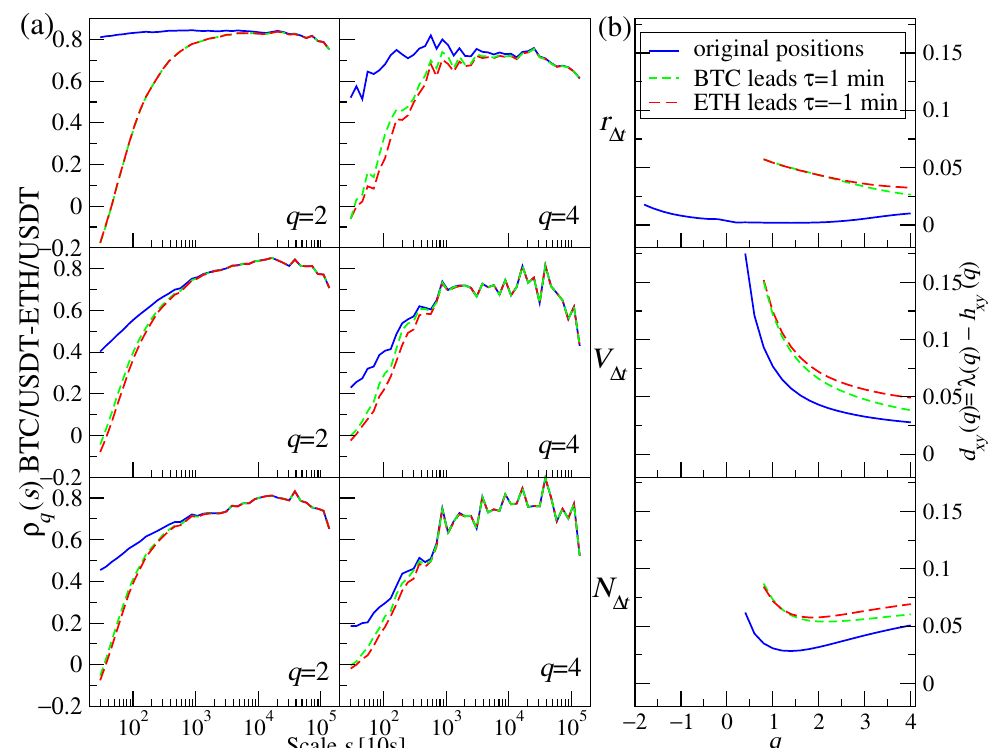
Figure 5. ( a ) The q -dependent detrended cross-correlation coefficient ρ q ( s ) for q = 2 ( left ) and q = 4 ( right ) calculated for time series of price returns r ∆ t ( t ) ( top ), volume traded V ∆ t ( t ) ( middle ), and the number of transactions N ∆ t ( t ) in ∆ t ( bottom ) for X = BTC and Y = ETH. Three cases are considered: both time series are simultaneous (solid blue), time series representing BTC is advanced by τ = 1 min (short-dashed green), and time series representing ETH is advanced by τ = 1 min (long-dashed red). ( b ) Difference d XY ( q ) between the bivariate scaling exponent λ ( q ) and the mean univariate exponent h XY ( q )